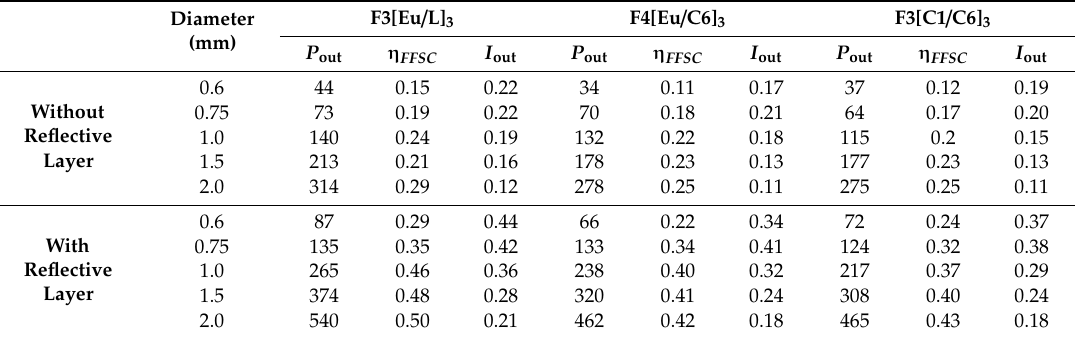
Figure 4. Output power ( a ); output irradiance ( b ); and η FFSC ( c ) for the three double-doped samples as functions of the fiber core diameter. Table 2. Output power in ( µ W), output irradiance in (mW / mm 2 ) and η FFSC in (%) for the three samples and di ff erent fiber diameters without and with a reflective layer at 4.5 cm from the